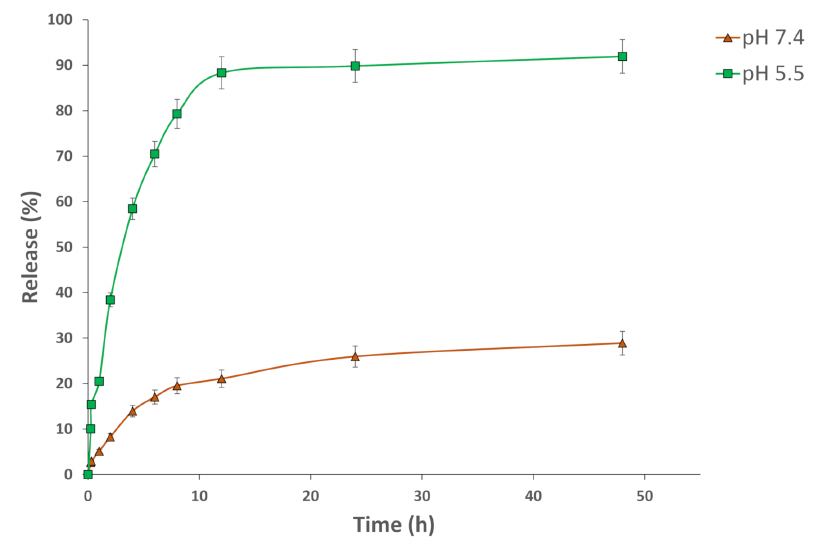
Figure 5. Time-dependent release profiles of asplatin at 37 ◦ C, into pH 5.5 (square) and pH 7.4 (triangle) in phosphate buffer